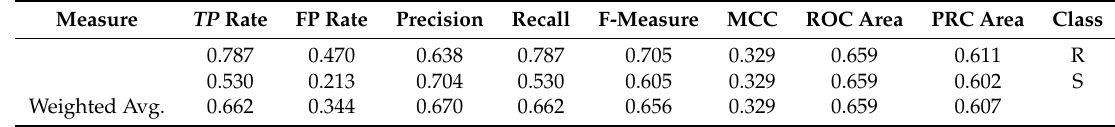
Table 4. Detailed accuracy by class of SMO (10-fold